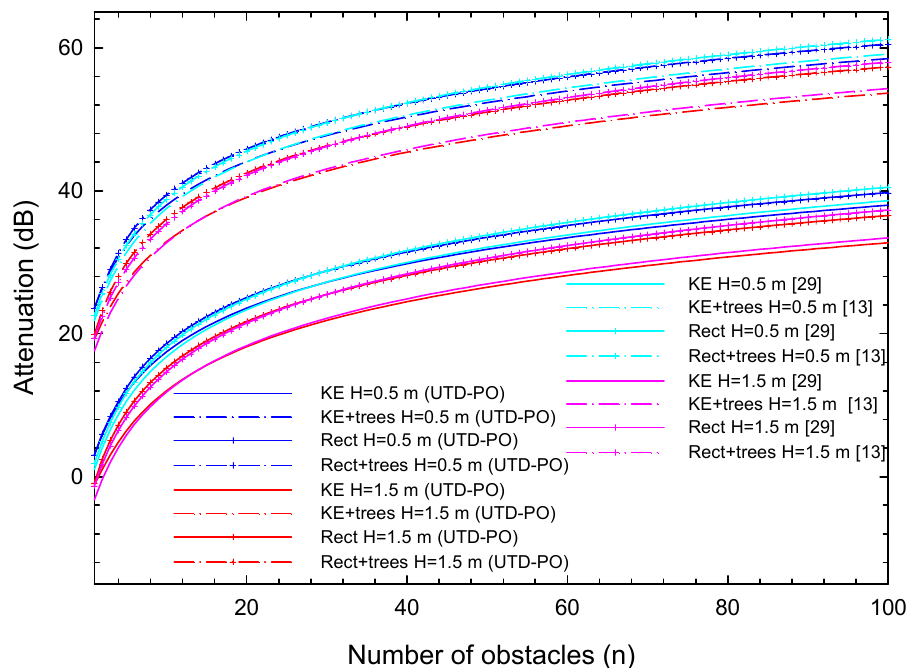
Figure 4. Attenuation obtained with the UTD-PO solutions (with and without trees) for buildings modeled as knife-edges and rectangular sections, as a function of the number of obstacles. Results obtained with models derived from [13,29] are also shown in the plot. Parameters of f = 3.5 GHz, d = 30 m, z = 50 m, w = 20 m, v = 30 m, relative permittivity of the bricks ε r = 4 + 0.28j, Δ d = 4 m, hard/vertical polarization, and the COST 235 foliage-attenuation model for the in-leaf case have been considered.